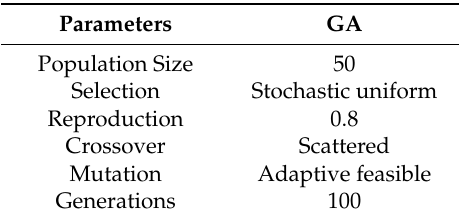
Table 1. Genetic algorithm (GA)